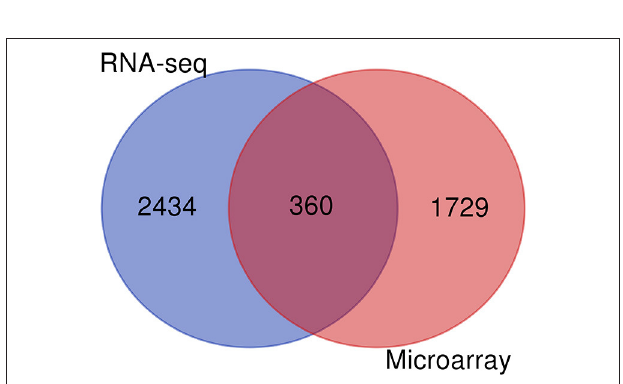
FIGURE 4 | Results of common meta-genes using Venn